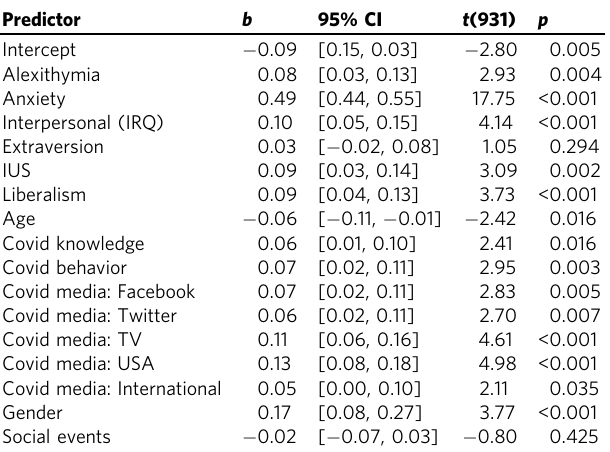
Table 2 Cross-validated regression model.